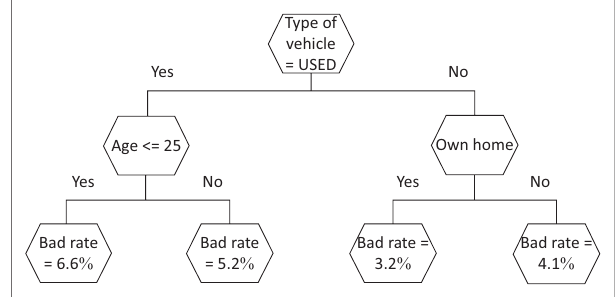
FIGURE 2: Decision TABLE 1: Non-parametric techniques assumptions. Assumption number